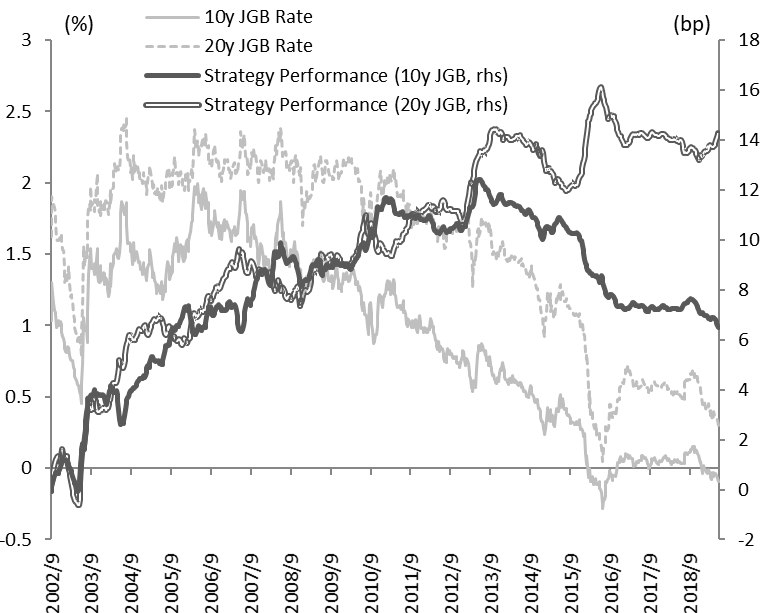
Figure 15. Interest rates and the result of the autoencoder-based investment strategies.